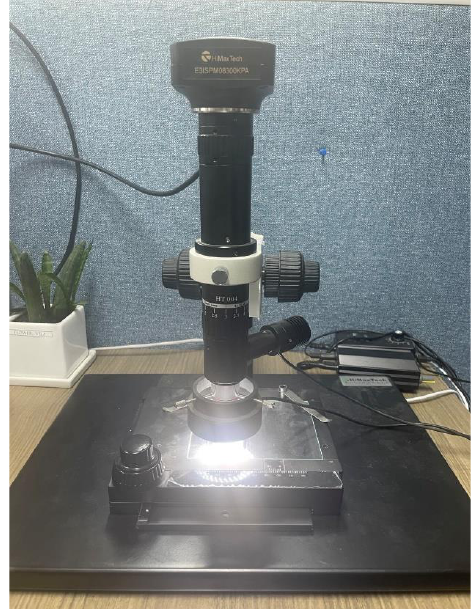
Figure 6. Optical microscope used for OM.